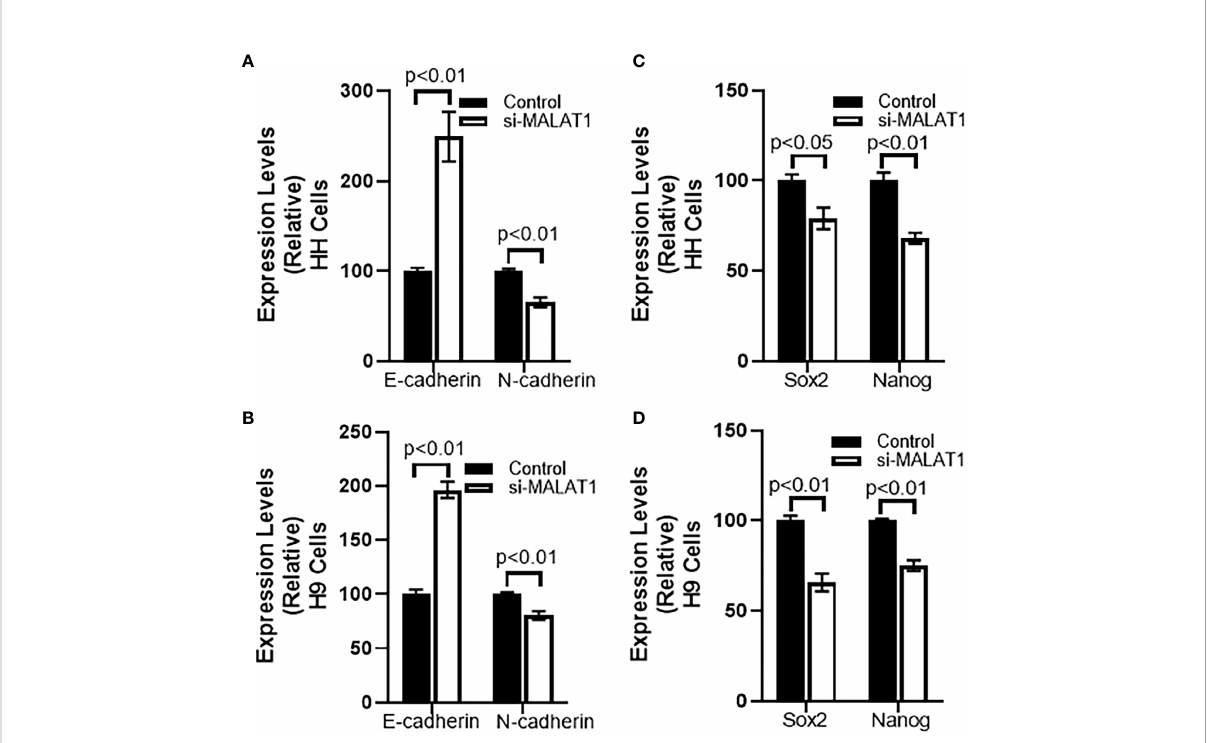
FIGURE 3 Effect of MALAT1 silencing on EMT and cancer stem cell characteristics of CTCL cells. Epithelial marker E-cadherin and mesenchymal marker N- cadherin was evaluated in HH (A) and H9 (B) cells upon MALAT1 silencing. Similarly, cancer stem cells markers Sox2 and Nanog were evaluated in HH (C) and H9 (D) cells upon MALAT1